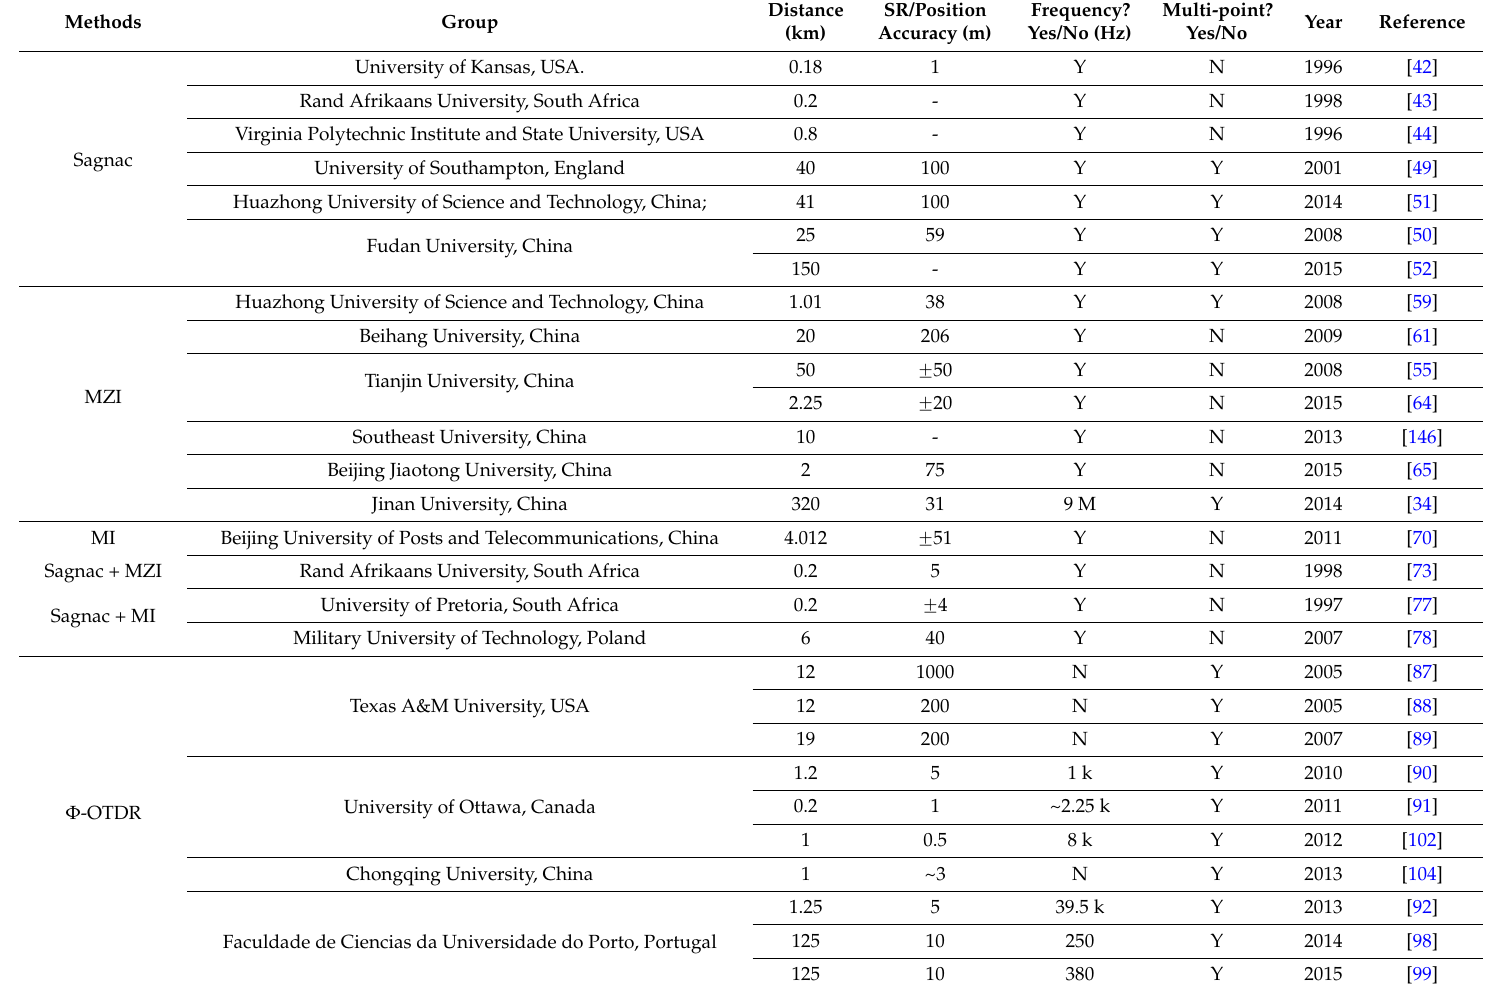
Table 1. Performance summary of distributed fiber-optic vibration